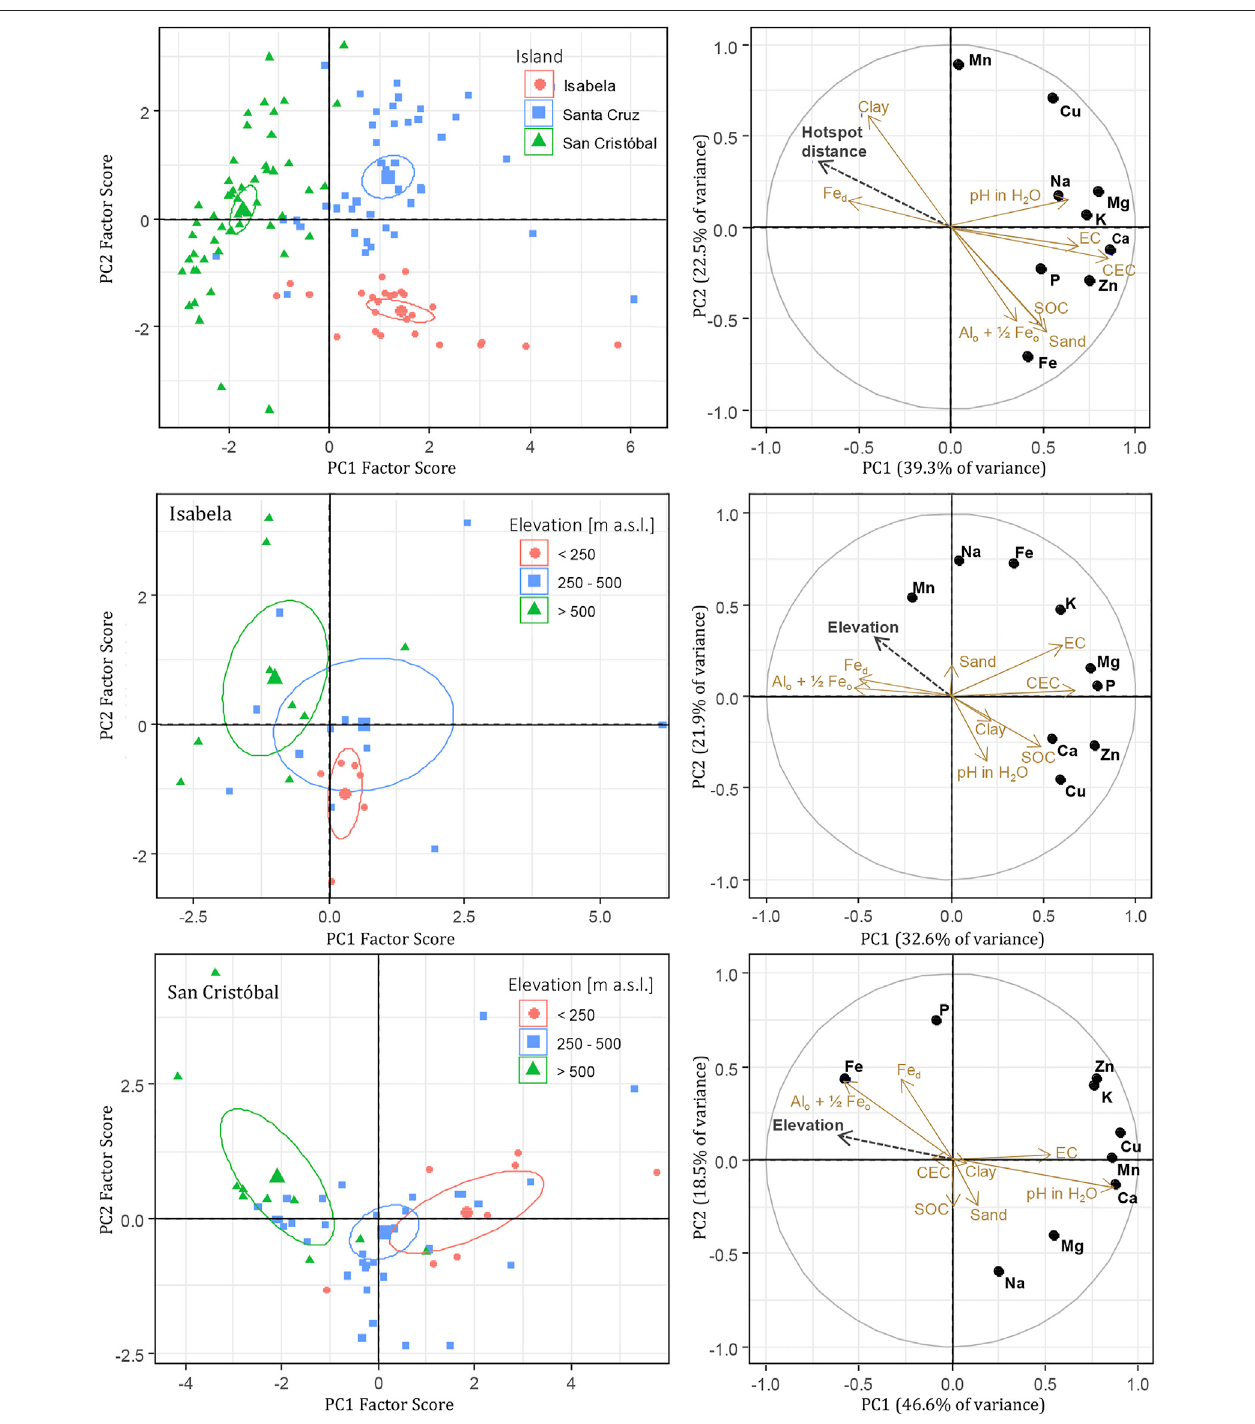
FIGURE 5 | Principal component analyses based on Mehlich (III)-extractable element concentrations for all studied islands (top) , Isabela (middle) and San Cristóbal (bottom) .Enlargedsymbolsandellipsesinthefactorscoresplots (leftside) indicatemeansand95%con fi denceintervals,respectively.Therightsidedisplays the loadings of the Mehlich (III)-extractable element concentrations (dots) and relationships with other parameters (arrows). EC (cid:1) electrical conductivity, CEC (cid:1) cation exchange capacity, SOC (cid:1) soil organic carbon, Fe d (cid:1) dithionite-extractable iron, Al o and Fe o (cid:1) oxalate-extractable aluminum and iron; m a.s.l. (cid:1) meters above sea